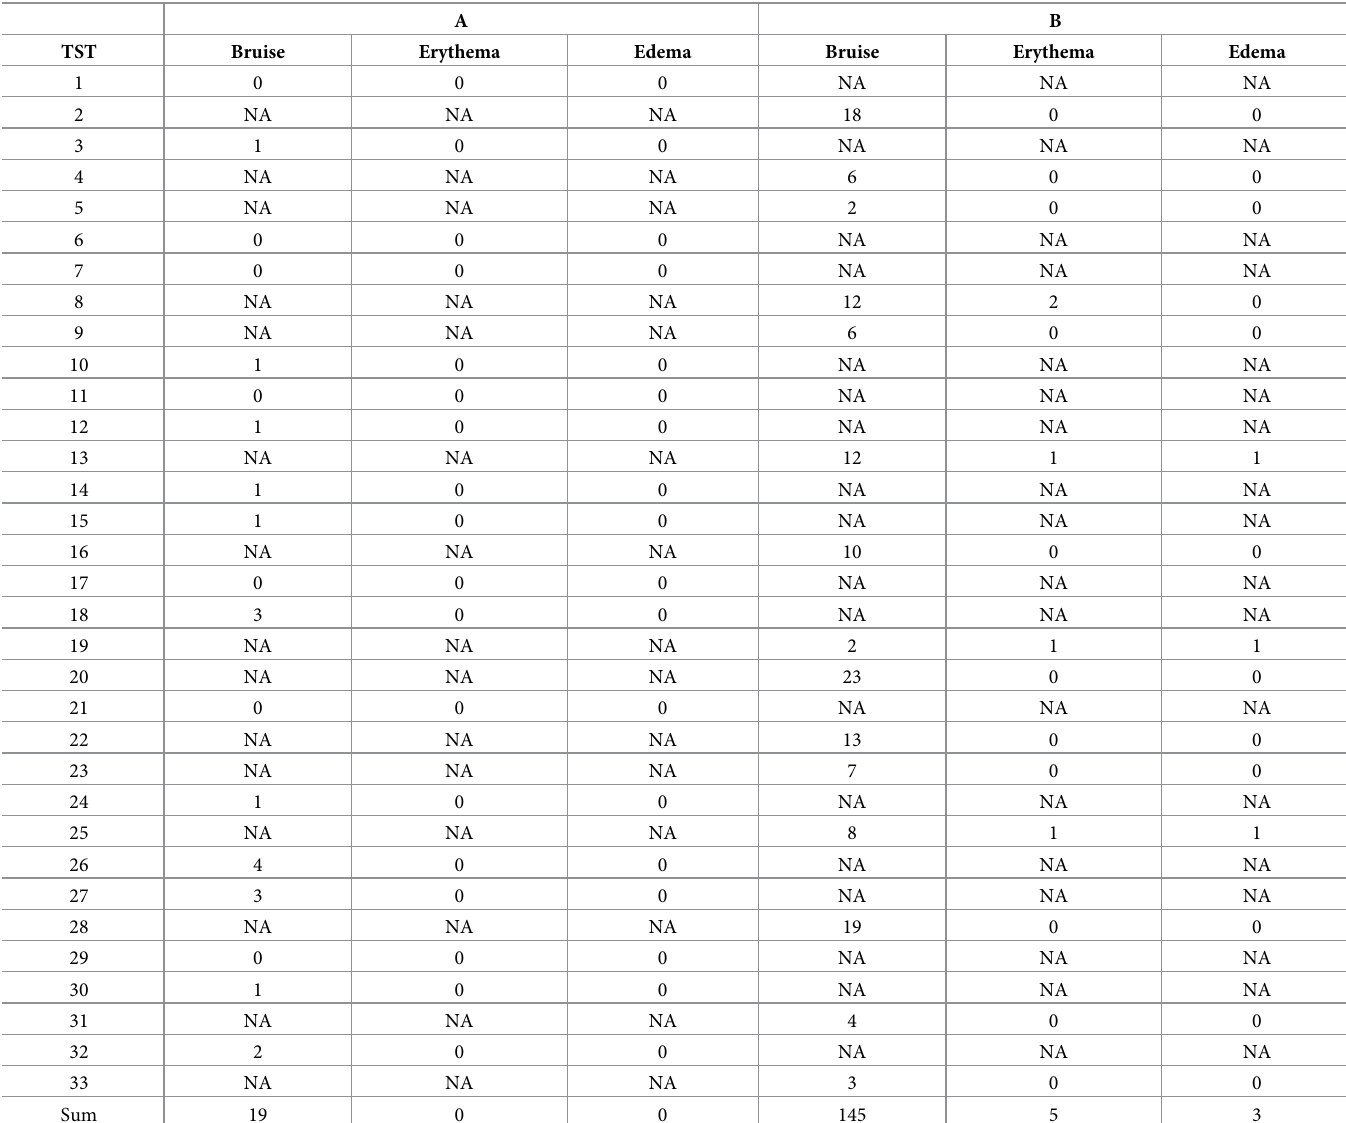
Table 5. Comparison of all animal reactions to MOT at 72 hours by